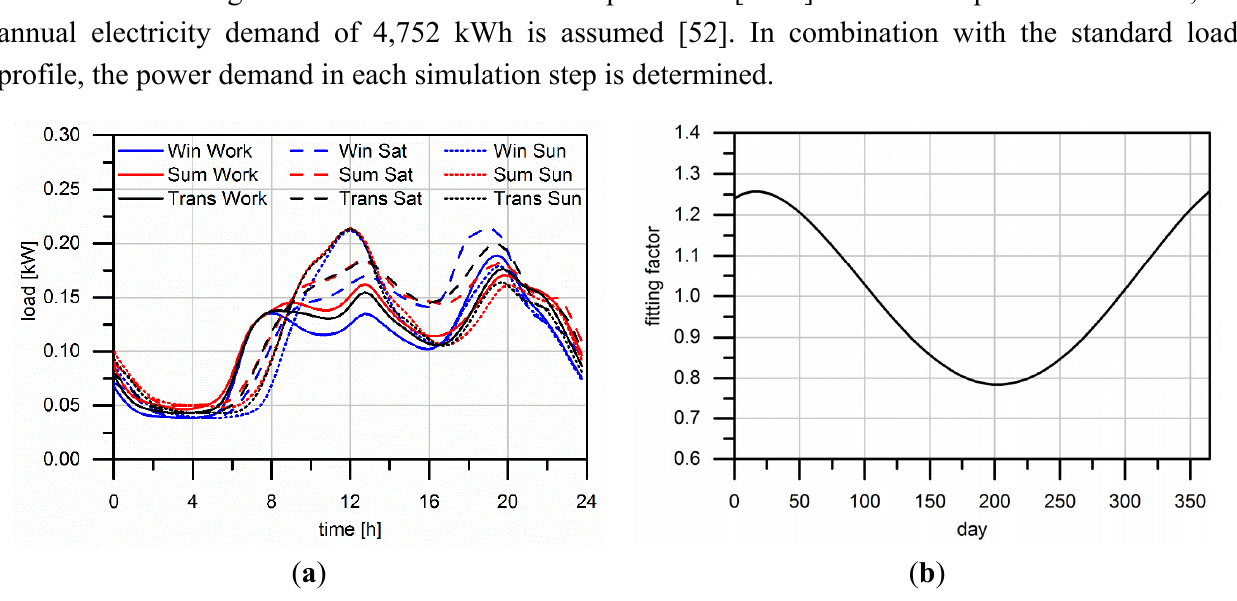
Figure 2. ( a ) Daily load profiles characterized by day and season type; ( b ) Fitting function to take into account seasonal